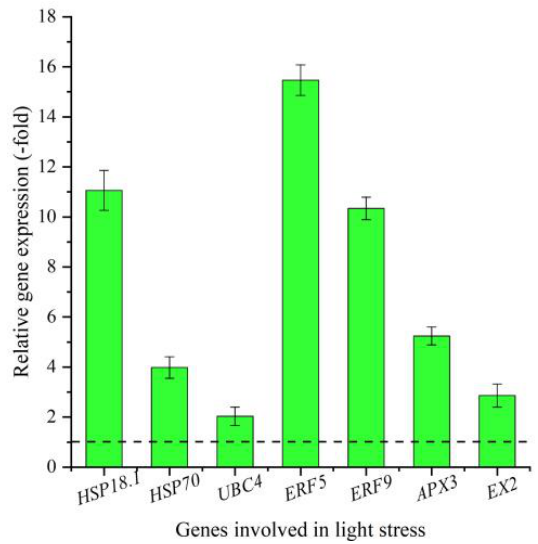
Figure 4. The REL of genes involved in light stress at 3300 m vs. 2300 m, as determined by qRT-PCR (mean ± SD, n =